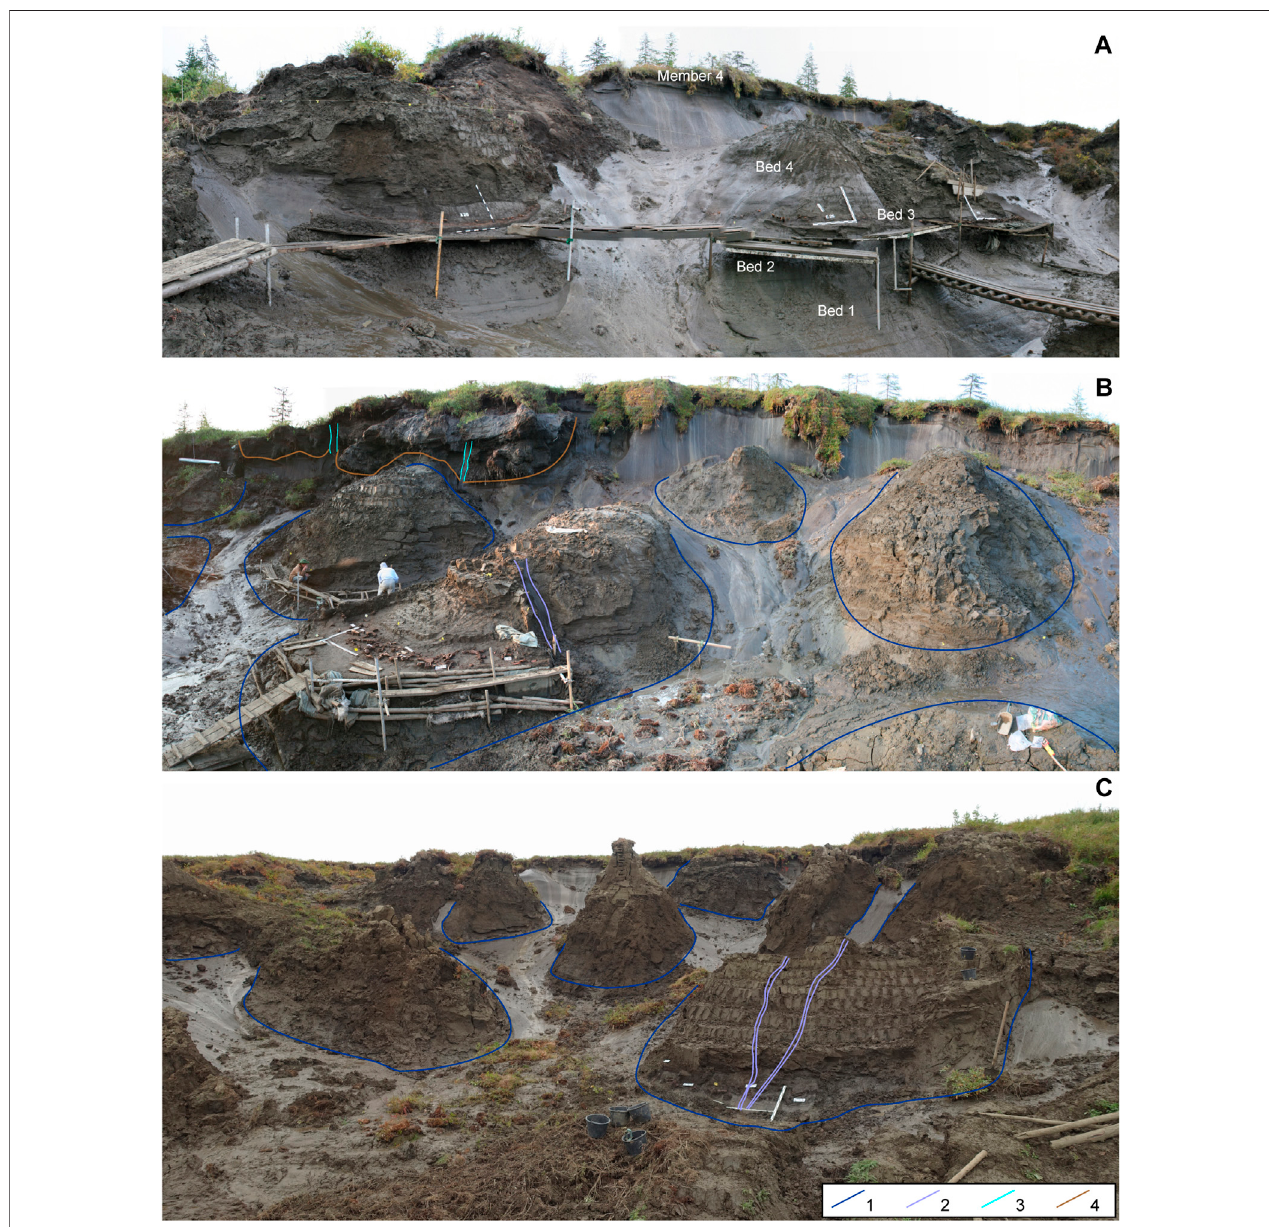
FIGURE 6 | Cryology of Member 3 deposits: (A , B) – Northern Point area; (C) – Yana B area of the Yana complex of sites. Illustration key: 1 — outlines of the fi rst generation of the late Pleistocene (MIS3) ice wedges; 2 — outlines of the second generation of the late Pleistocene (MIS2) ice wedges initiated at the LGM; 3 — Holocene ice veins; 4 — base of the peaty deposits of Member 4 of Holocene